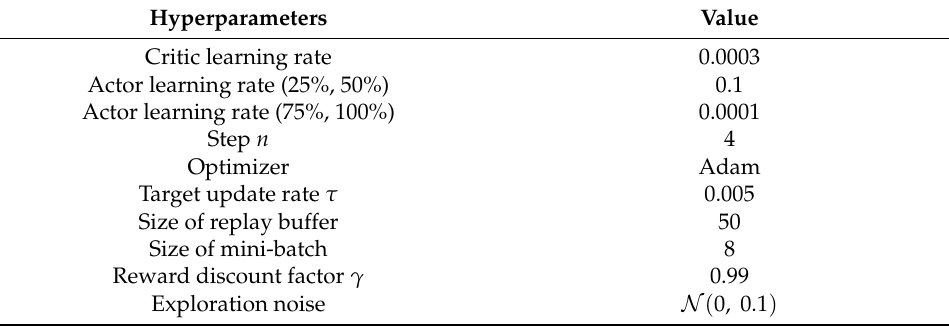
Figure 4. Adjustment parameter results: ( a ) number of steps; ( b ) critic learning rate; ( c ) replay buffer. The hyperparameters set in the experiment are shown in Table 1. Table 1. AQMDRL training